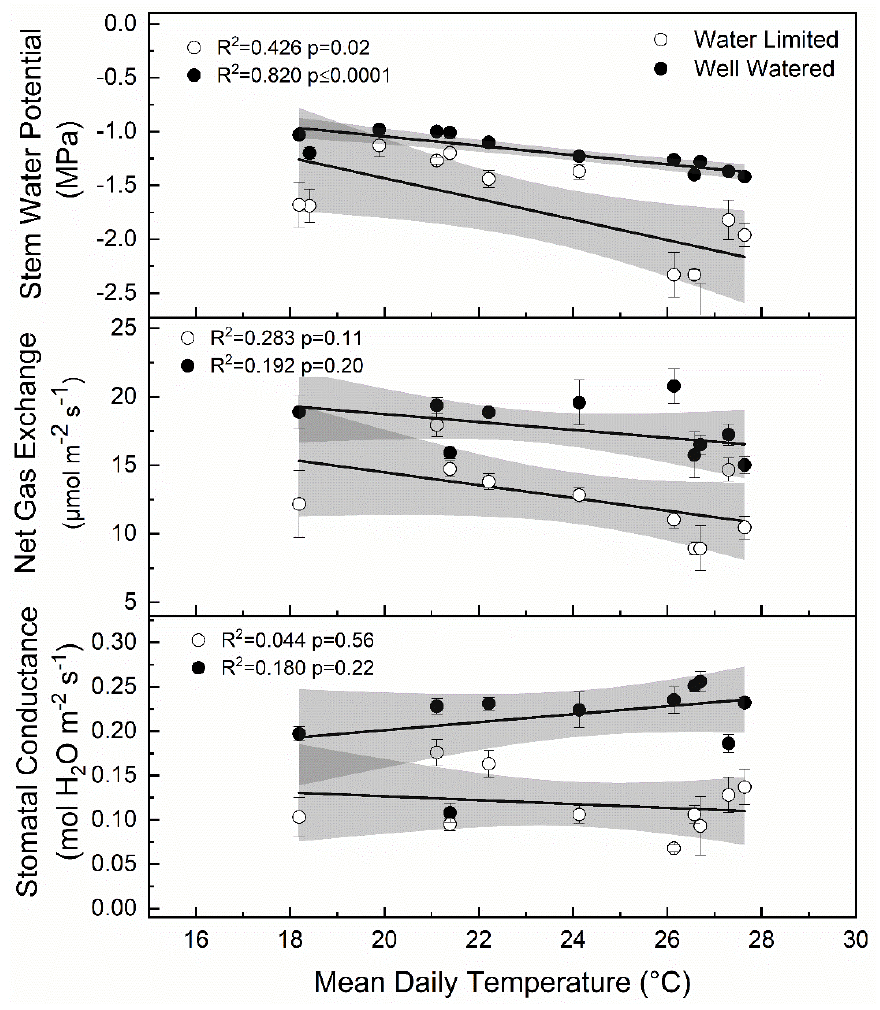
Figure 10. Linear relationship between mean daily temperature for 15 days prior to each measurement period and stomatal conductance, net gas exchange, and stem water potential for apple trees exposed to water limiting conditions (open circles) versus well-watered control (closed circles) in 2017 and 2018. Grey shaded sections represent the 95% confidence bands for the linear correlation shown by the black line.